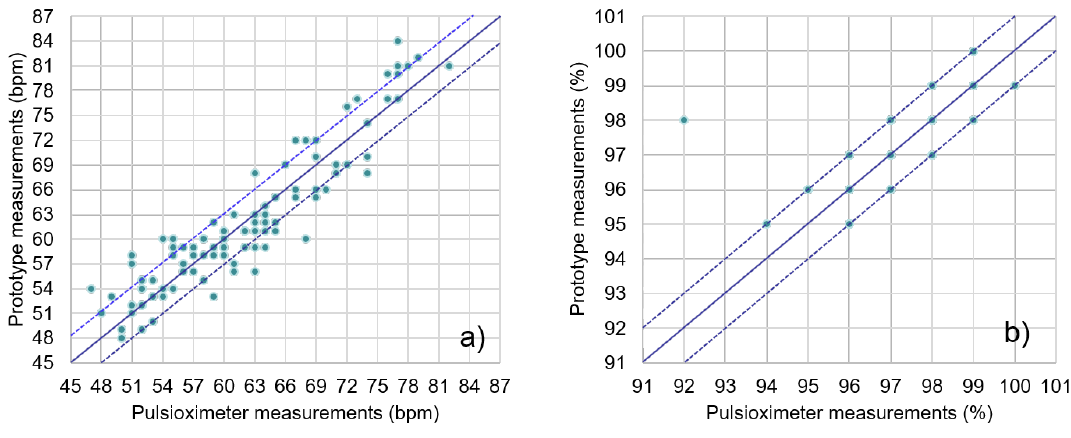
Figure 10. Beats per minute (BPM) ( a ) and SpO 2 ( b ) results compared to a clinical pulse oximeter (dotted lines represent ± 3-BPM and ± 1% deviations,